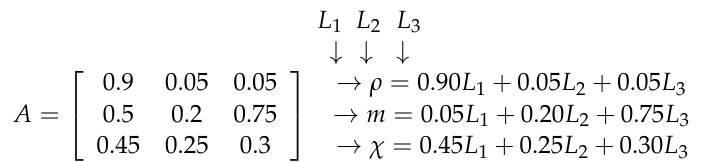
Figure 4. Three independent geological features contribute to the bulk physical properties ( a ). The background lithology has three components ( b – d ), which is intruded by a dyke ( e ) and overprinted by two successive alteration events ( f